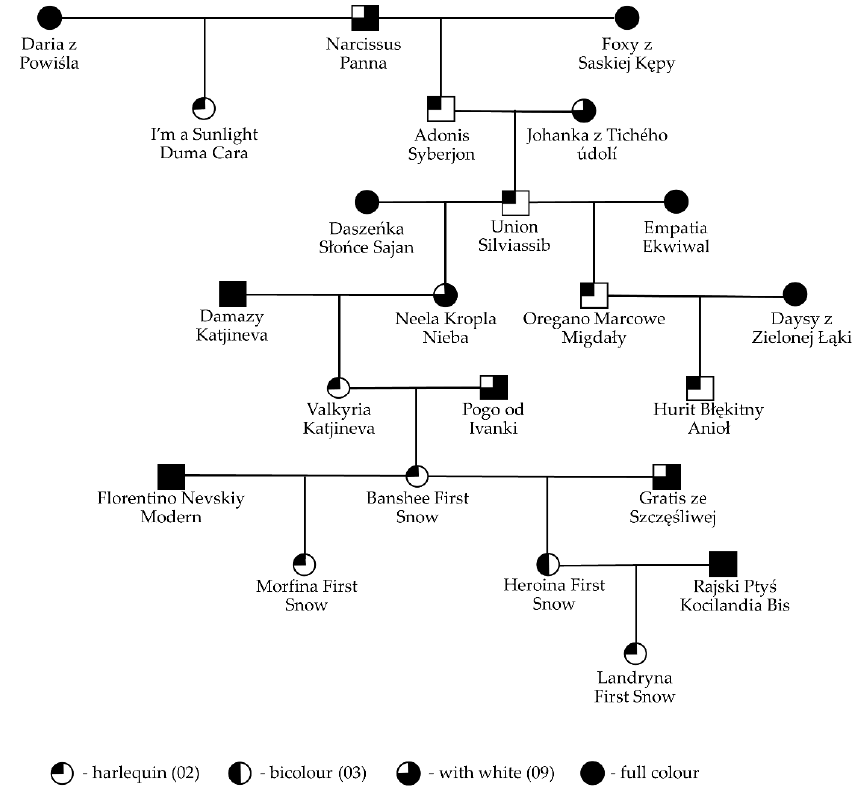
Figure 2. Representative pedigree for large amounts of white spotting inheritance. All cats with white spotting gene (including Union Silviassib, Banshee First Snow and Heroina First Snow) are heterozygous cats ( Ss ) based on phenotype and pedigree information.